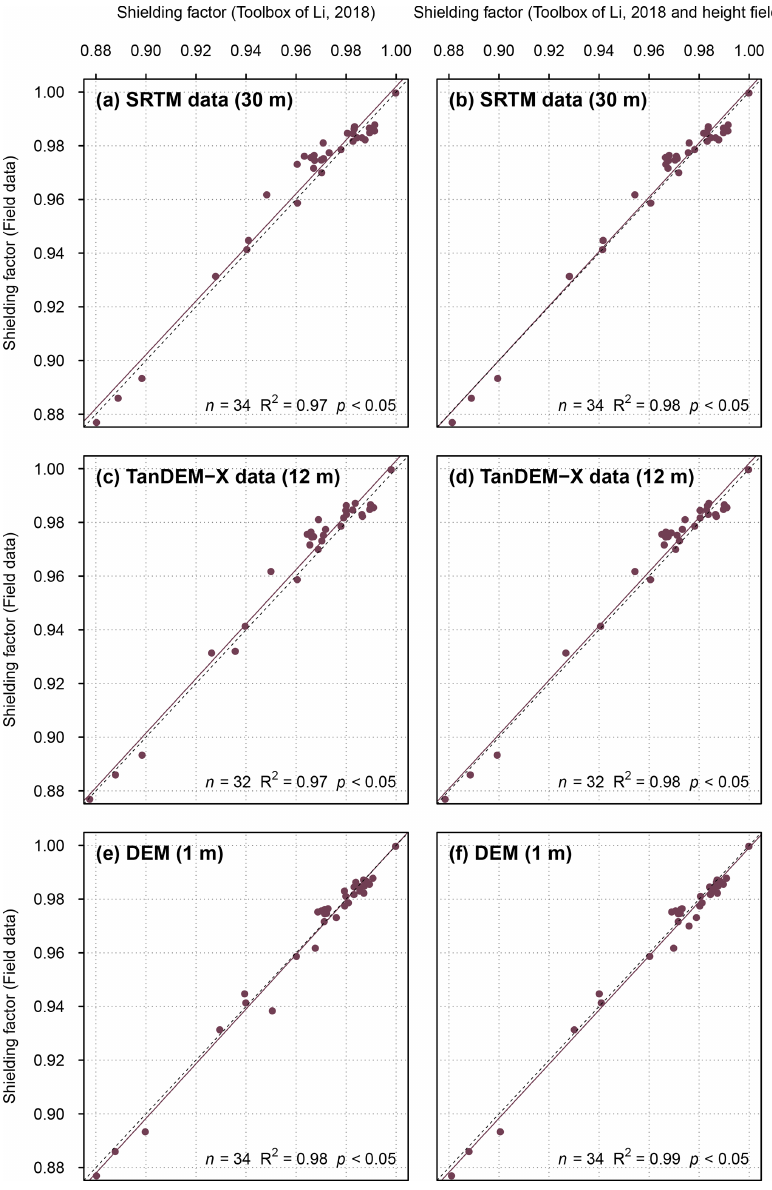
Figure C1. (a) SRTM DSM-based shielding factors versus field-data-based shielding factors. Problematic shielding factors for the FS-1a, FS-2a and SW-2 boulders were excluded from analysis. Panel (b) is the same as (a) , but SRTM DSM-based shielding factors were corrected for the boulder height. (c) TanDEM-X DEM-based shielding factors versus field-data-based shielding factors. Problematic shielding factors for the FS-1a, FS-2a and SW-2 boulders were excluded from analysis. Panel (d) is the same as (c) , but TanDEM-X DEM-based shielding factors were corrected for the boulder height. (e) Shielding factors determined with the 1m DEM versus field-data-based shielding factors. Problematic shielding factors for the FS-1a, FS-2a and SW-2 boulders were excluded from analysis. Panel (f) is the same as (e) , but GIS-based shielding factors were corrected for the boulder